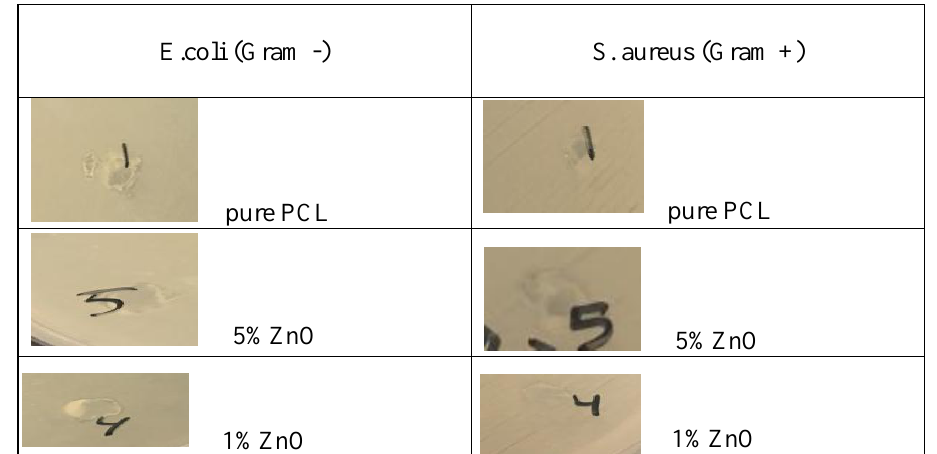
Fig.7: Ant-bacterial activity for pure PCL and PCL/ZnO nanocomposites at 1% wt and 5%wt.